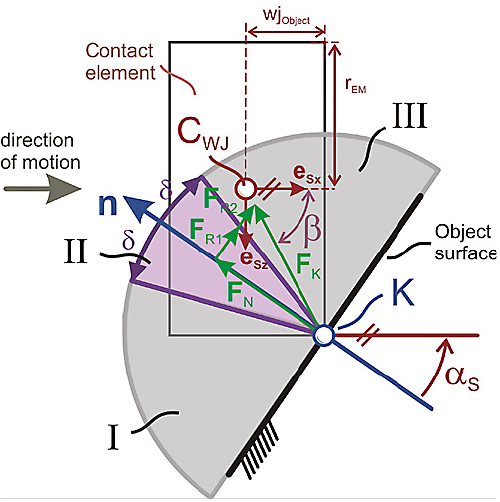
Figure 11. Force condition at contact point while